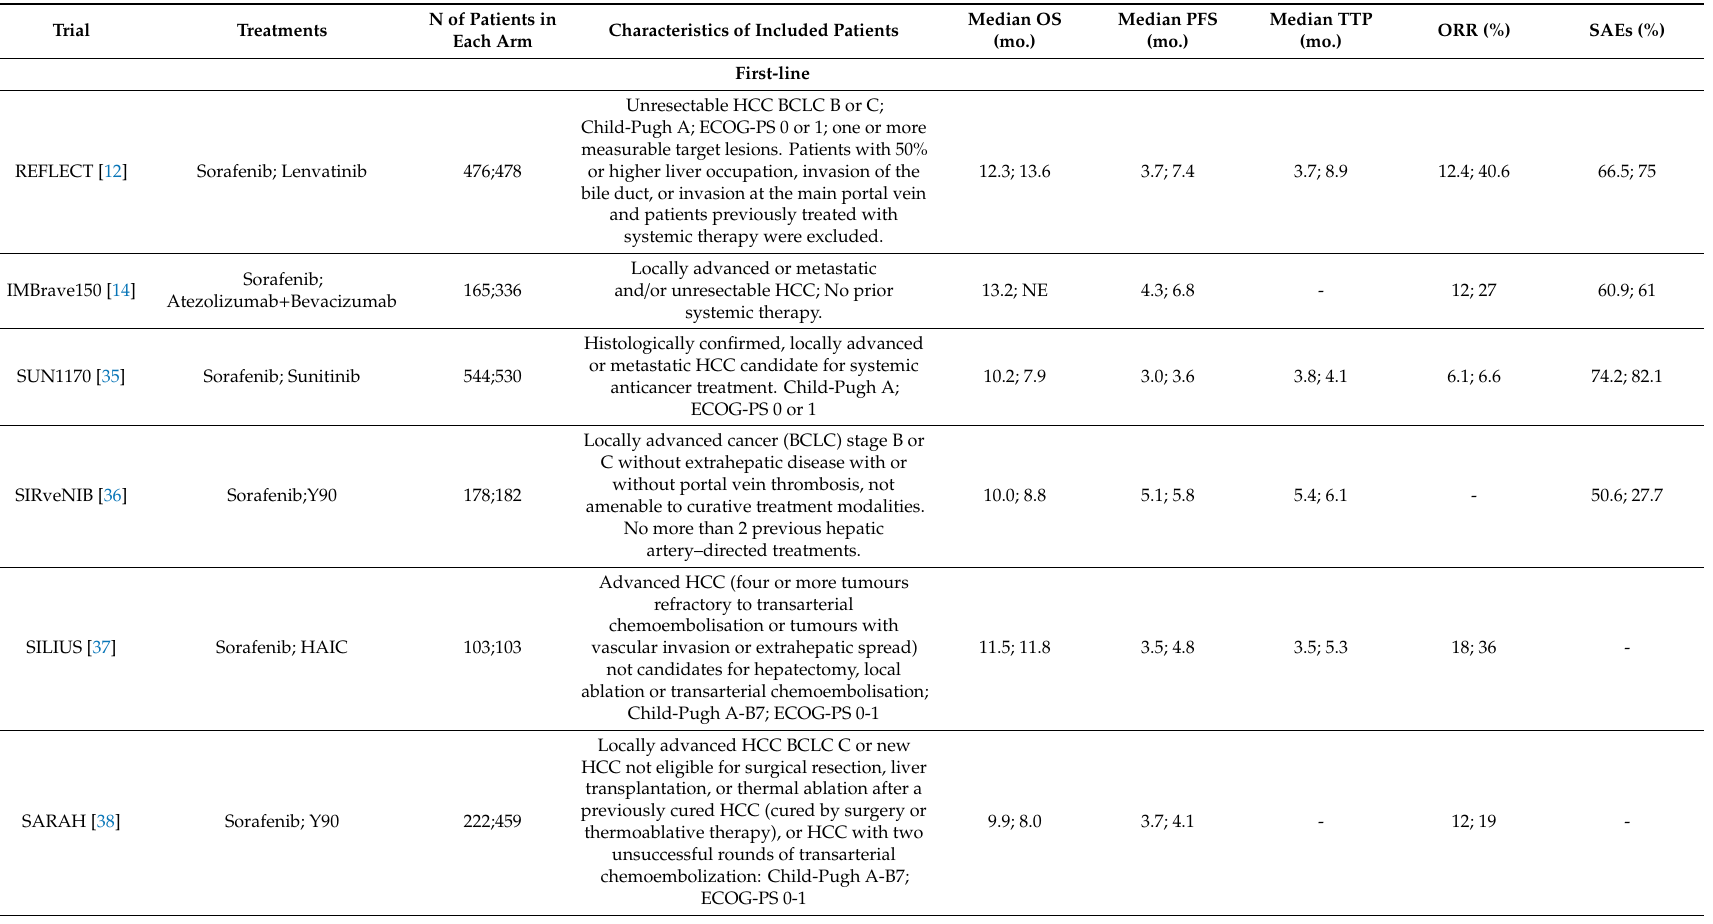
Table A1. Characteristics of the clinical trials from which model data were